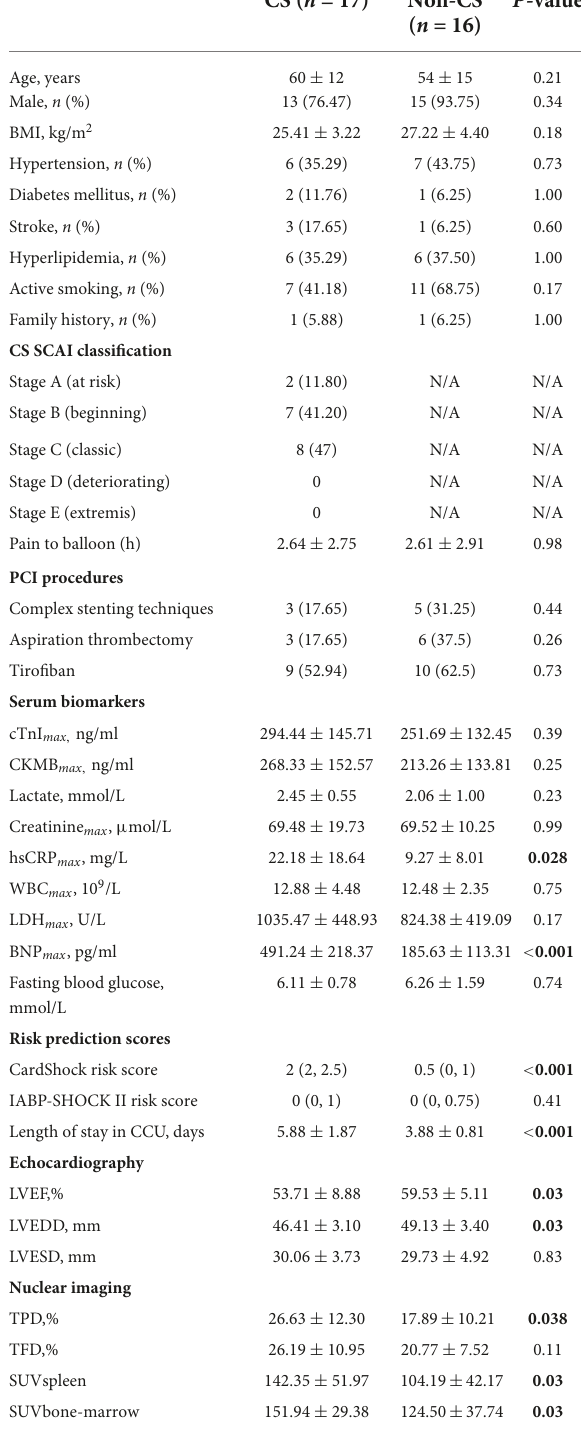
TABLE 1 Baseline